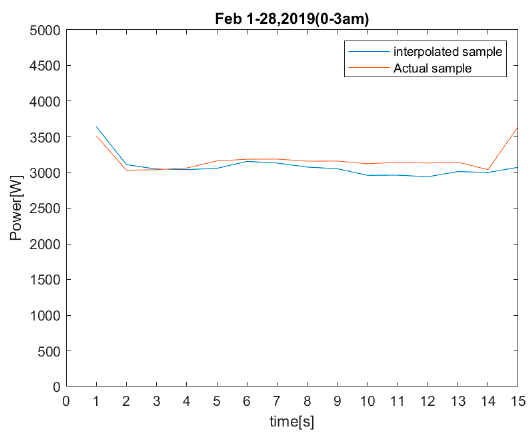
Figure 5. Load interpolation.